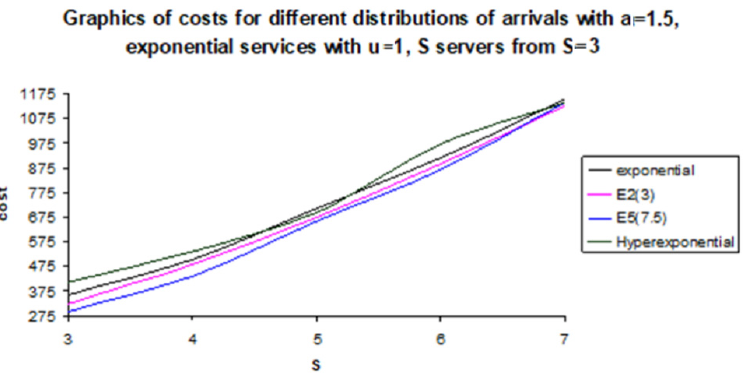
Figure 10. Graphics of costs for different distributions of arrivals.